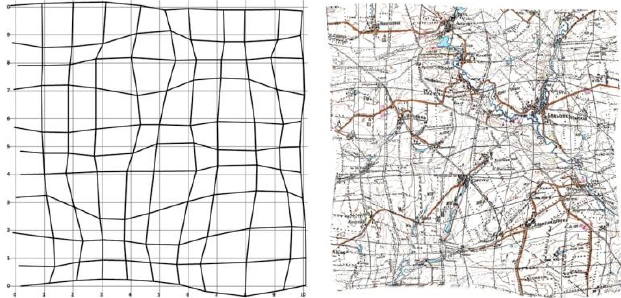
Fig. 9. Integral matrix anamorphosis and the corresponding map of the area which is built using morphing.